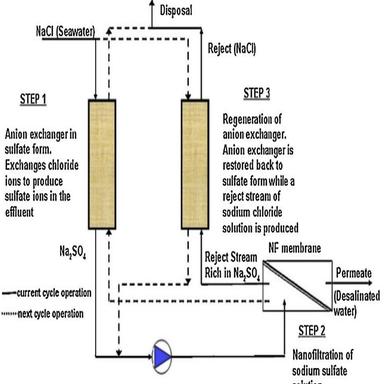
Schemetic diagram of the HIX-NF membrane process.